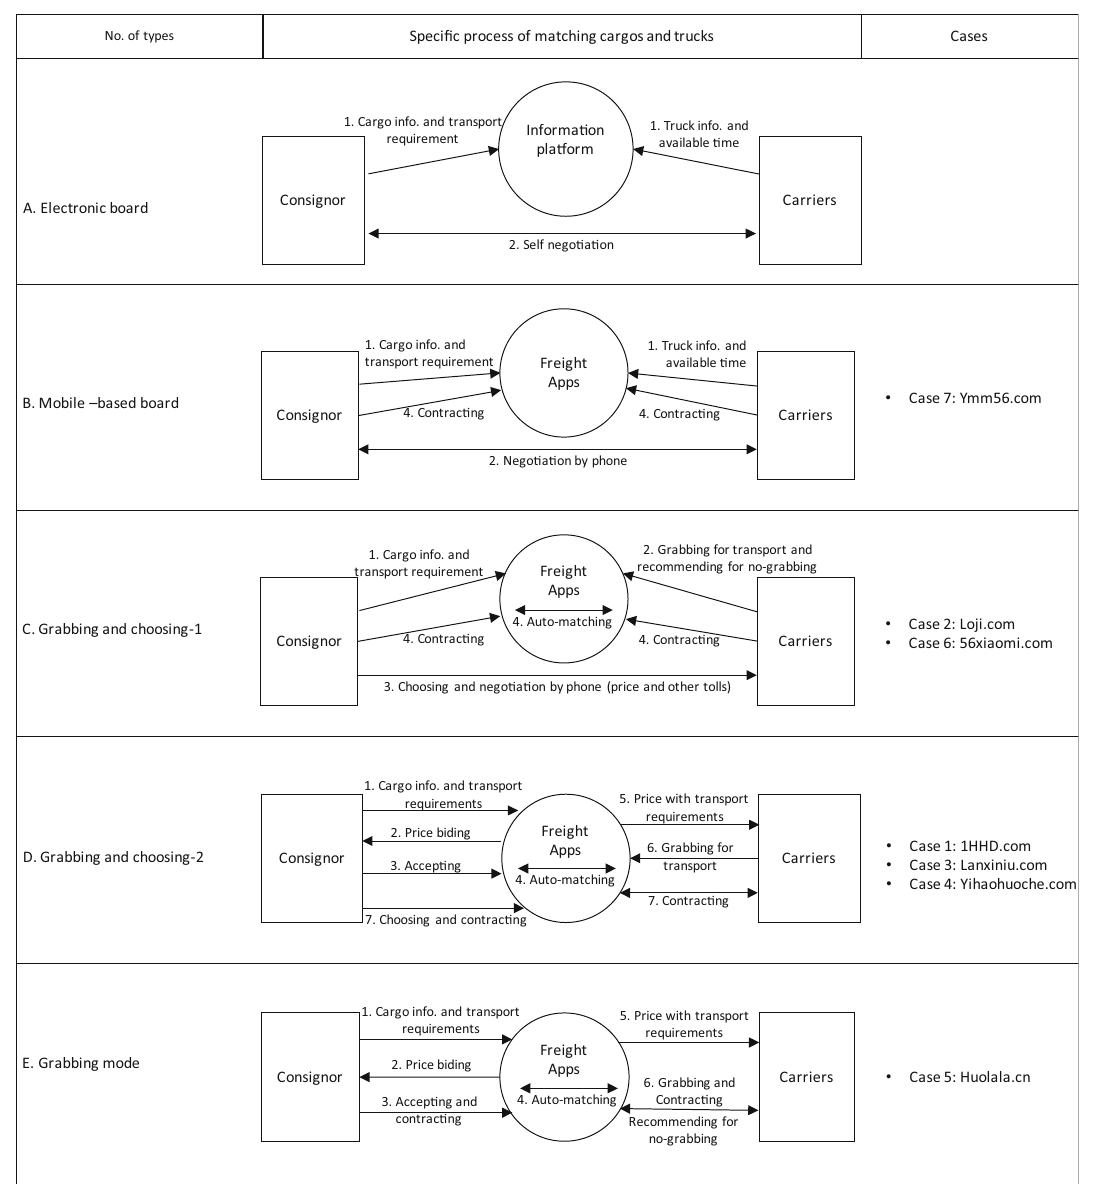
Fig. 2 Mode types to match cargos and